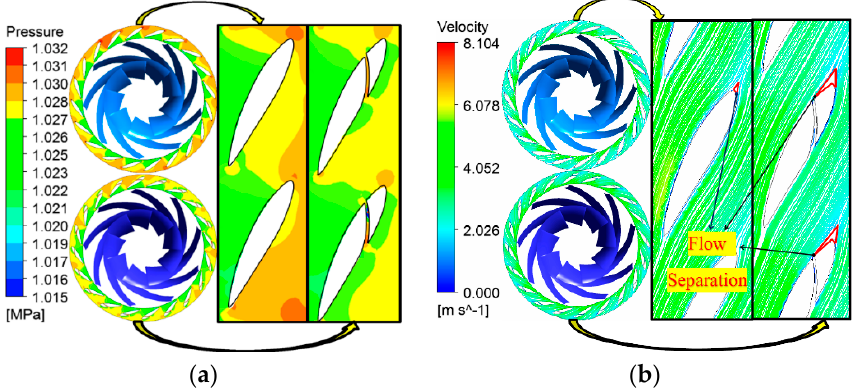
Figure 12. Influence of the “Groove Method” on the pressure and flow field under the design point. ( a ) Pressure field; ( b ) Flow field.